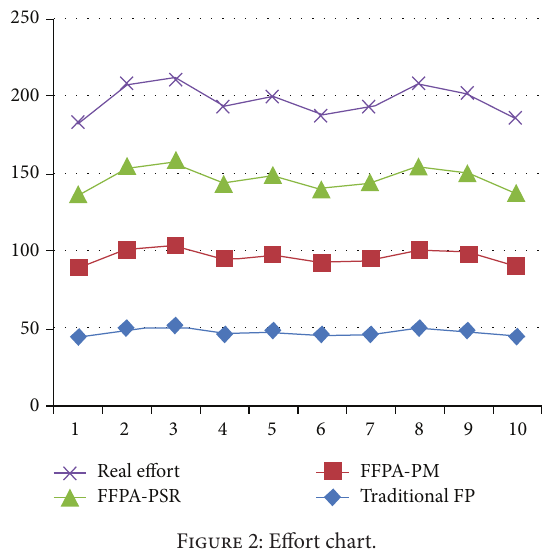
Figure 3: Comparison of the MMRE and PRED.